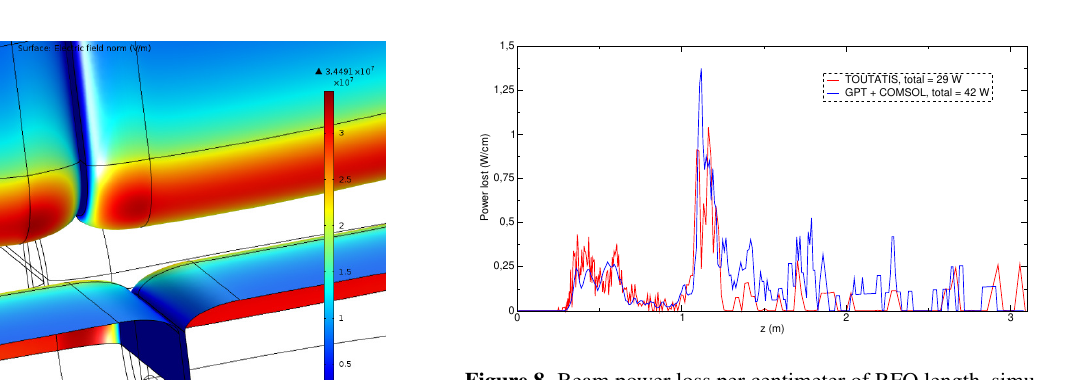
Figure 8. Beam power loss per centimeter of RFQ length, simu- lated with two di ff erent